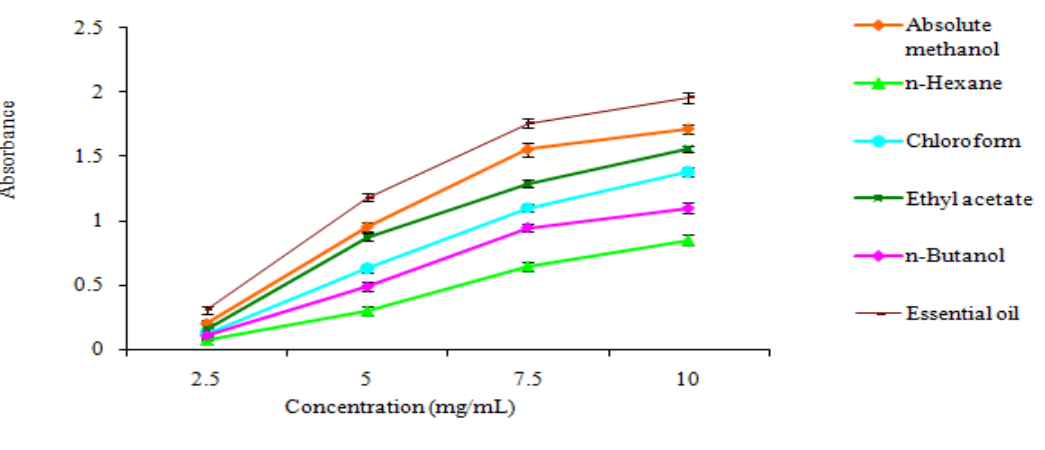
Figure 2. Reducing power of extract, fractions and essential oil of M. goodenifolius